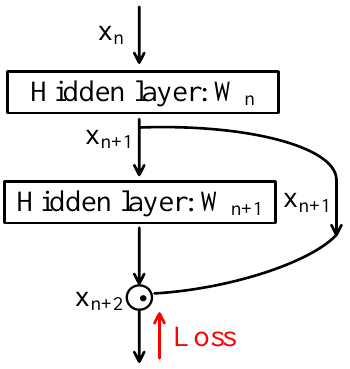
Figure 4. Simplified model of SSE module.